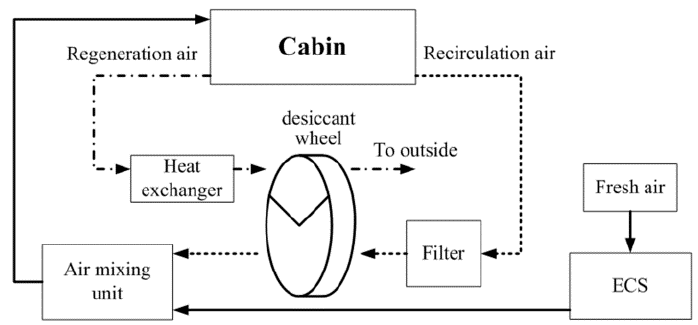
Figure 1. Desiccant wheel-based air purification system diagram.